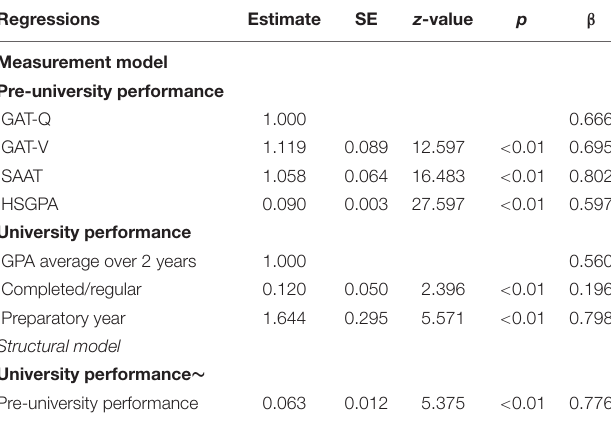
TABLE 4 | Unstandardized parameter estimates for the level 1 structural equations model.